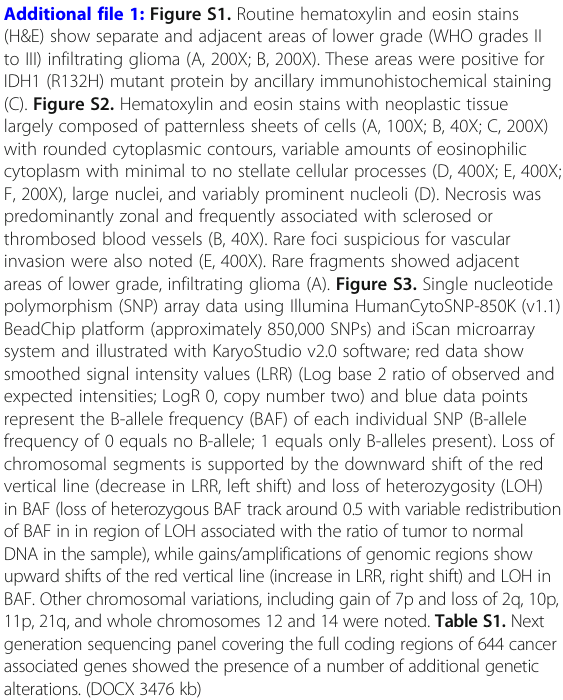
(C). Figure S2. Hematoxylin and eosin stains with neoplastic tissue largely composed of patternless sheets of cells (A, 100X; B, 40X; C, 200X) with rounded cytoplasmic contours, variable amounts of eosinophilic cytoplasm with minimal to no stellate cellular processes (D, 400X; E, 400X; F, 200X), large nuclei, and variably prominent nucleoli (D). Necrosis was predominantly zonal and frequently associated with sclerosed or thrombosed blood vessels (B, 40X). Rare foci suspicious for vascular invasion were also noted (E, 400X). Rare fragments showed adjacent areas of lower grade, infiltrating glioma (A). Figure S3. Single nucleotide polymorphism (SNP) array data using Illumina HumanCytoSNP-850K (v1.1) BeadChip platform (approximately 850,000 SNPs) and iScan microarray system and illustrated with KaryoStudio v2.0 software; red data show smoothed signal intensity values (LRR) (Log base 2 ratio of observed and expected intensities; LogR 0, copy number two) and blue data points represent the B-allele frequency (BAF) of each individual SNP (B-allele frequency of 0 equals no B-allele; 1 equals only B-alleles present). Loss of chromosomal segments is supported by the downward shift of the red vertical line (decrease in LRR, left shift) and loss of heterozygosity (LOH) in BAF (loss of heterozygous BAF track around 0.5 with variable redistribution of BAF in in region of LOH associated with the ratio of tumor to normal DNA in the sample), while gains/amplifications of genomic regions show upward shifts of the red vertical line (increase in LRR, right shift) and LOH in BAF. Other chromosomal variations, including gain of 7p and loss of 2q, 10p, 11p, 21q, and whole chromosomes 12 and 14 were noted. Table S1.